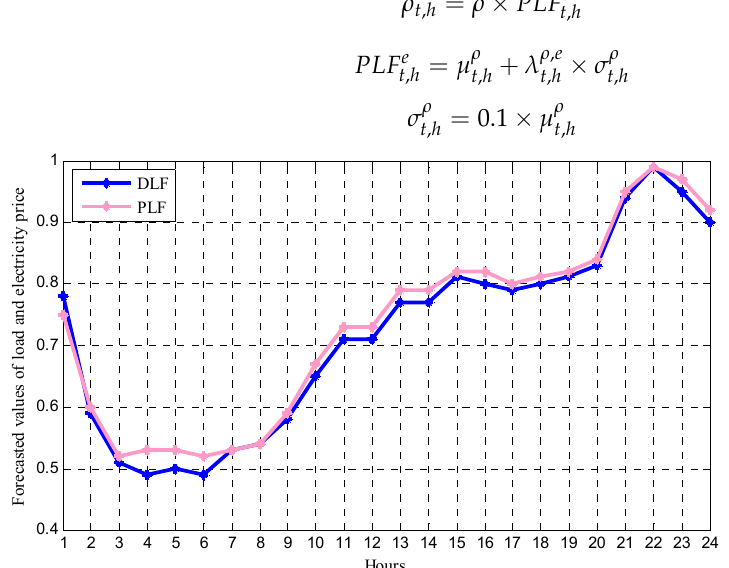
Figure 1. Price level curve.